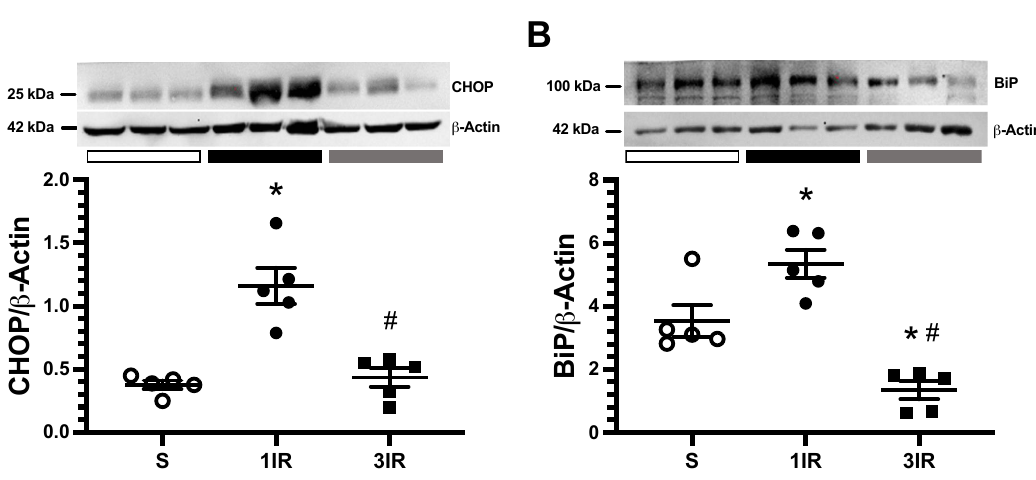
Figure 6. Repeated episodes of IR are associated with lesser endoplasmic reticulum stress. ( A ) CHOP and ( B ) BiP protein expression in renal cortex assessed by Western blot analysis. The sham group is represented in white circles, the 1IR group in black circles, and the 3IR group in black squares. * p < 0.05 vs. S, # p < 0.05 vs. 1IR group.